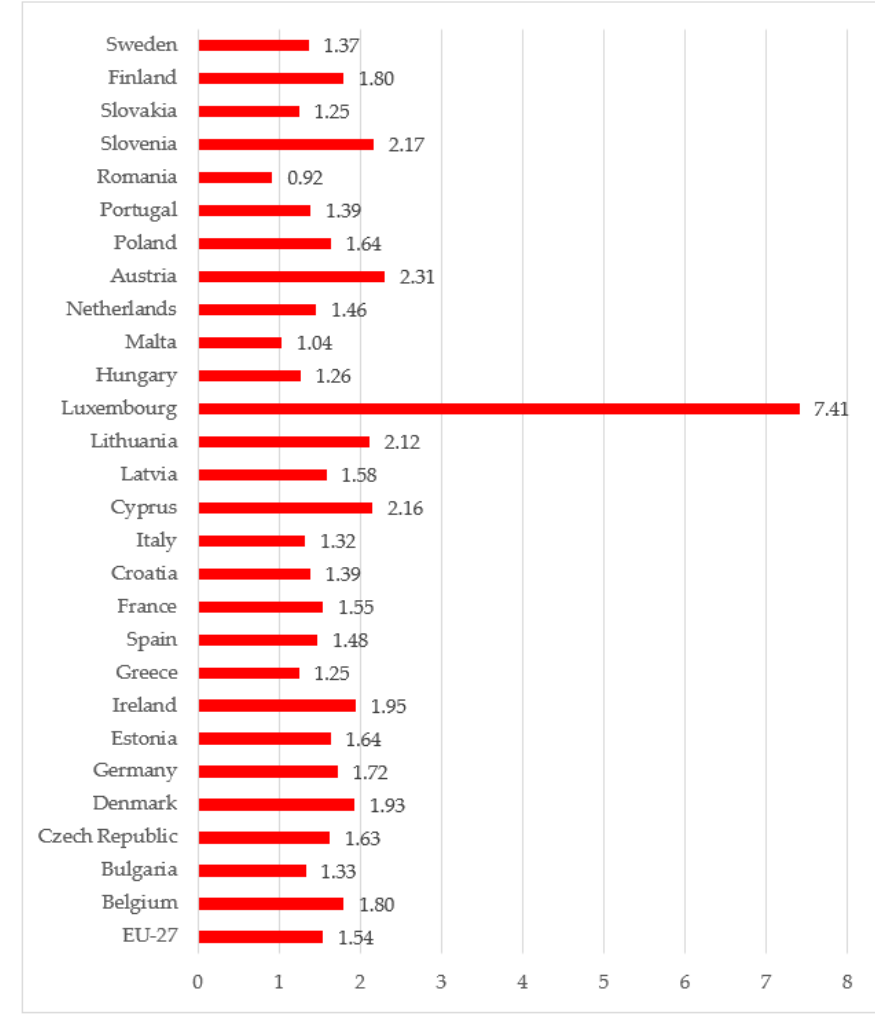
Figure 2. GHG emissions from fuel combustion in road transport in EU countries in 2020, tonnes/person. Source: [74].